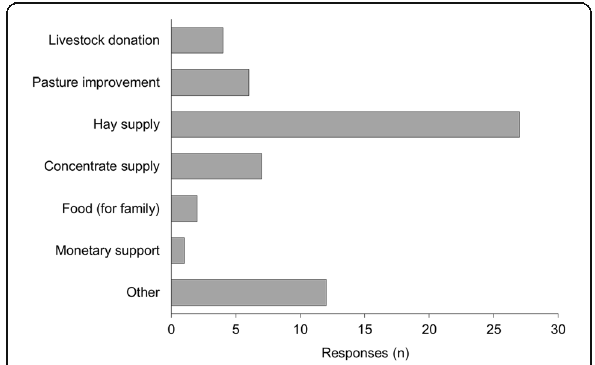
Figure 5 Expectations of 50 interviewed herders towards actions of the local government in the aftermath of dzud in the Mongolian Altai. Multiple answers were